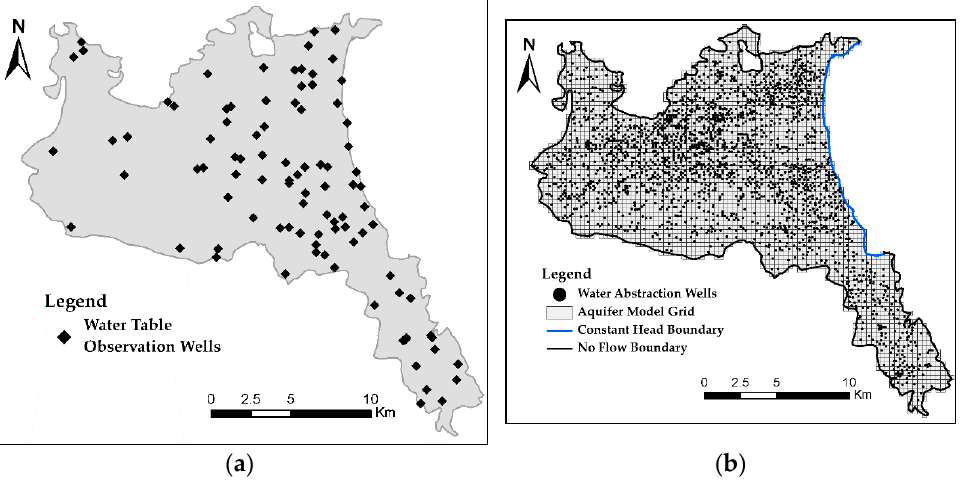
Figure 4. ( a ) Locations of water table observation wells and ( b ) locations of groundwater abstraction wells. concentrations are presented in Figure 5a,b, respectively.